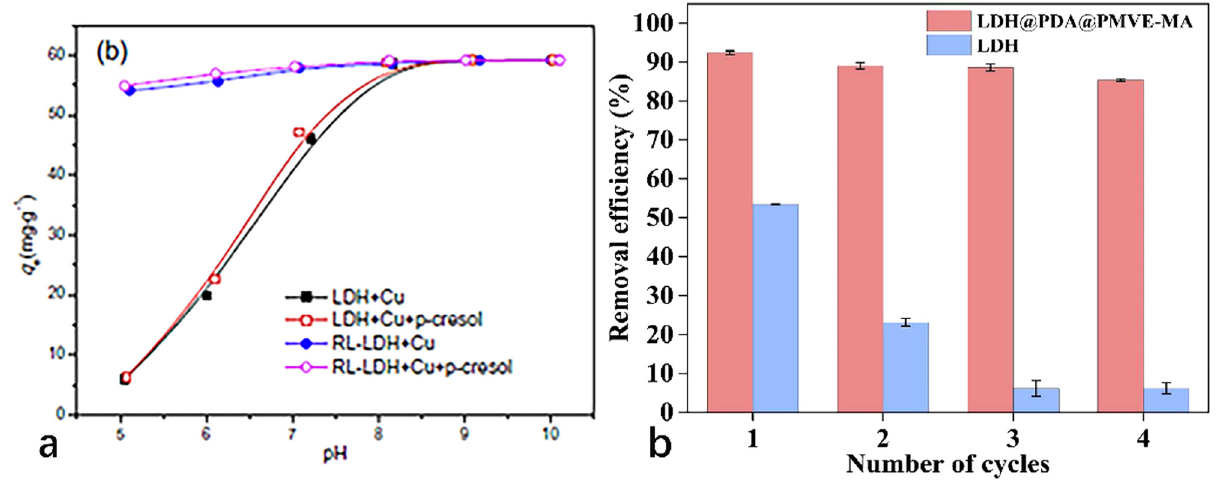
Figure 12: The stability ( a ) [ 76 ] and recyclability ( b ) [ 86 ] of functionalized LDH and pristine